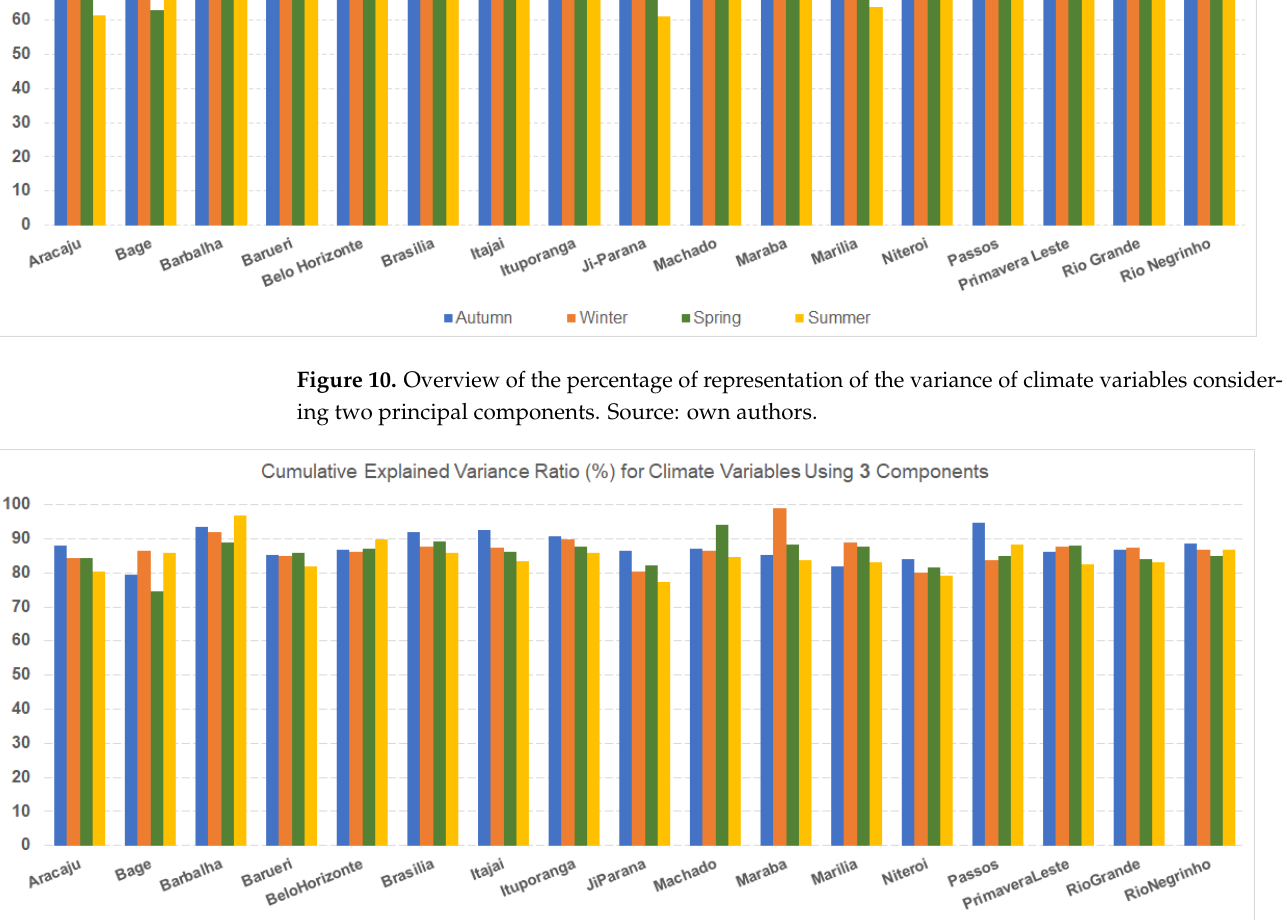
Figure 10. Overview of the percentage of representation of the variance of climate variables consid- ering two principal components. Source: own authors.